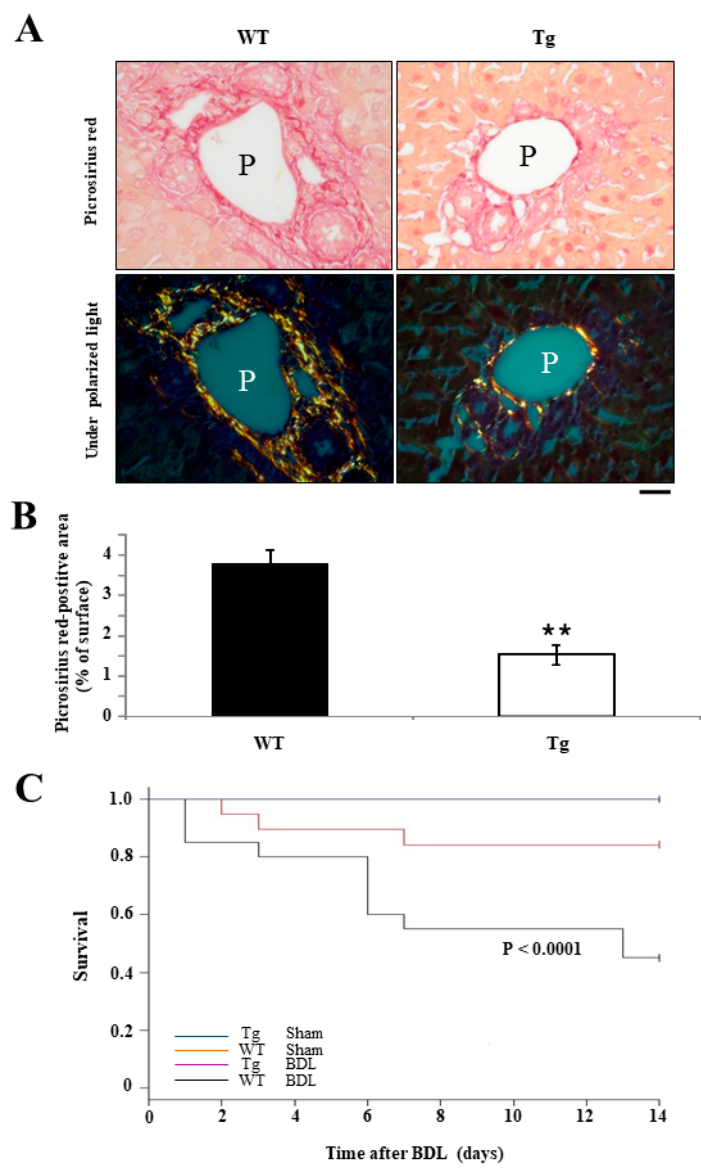
Figure 6. Analyses of peribiliary fibrosis and mortality in BDL mice. ( A ) Picrosirius red staining revealed evidence of significantly greater peribiliary fibrosis in WT mice on day 7 after BDL surgery than in hPRDX4 ‐ Tg mice. P, portal vein. ( B ) The mortality rate was significantly lower in hPRDX4 ‐ Tg mice on day 7 after BDL surgery than in WT mice; nevertheless, there were no deaths in the control group during the study period. p Values were calculated using Welch’s t ‐ test. The values represent the mean ± SD. Bar = 100 µm ** p < 0.001, n = 15.